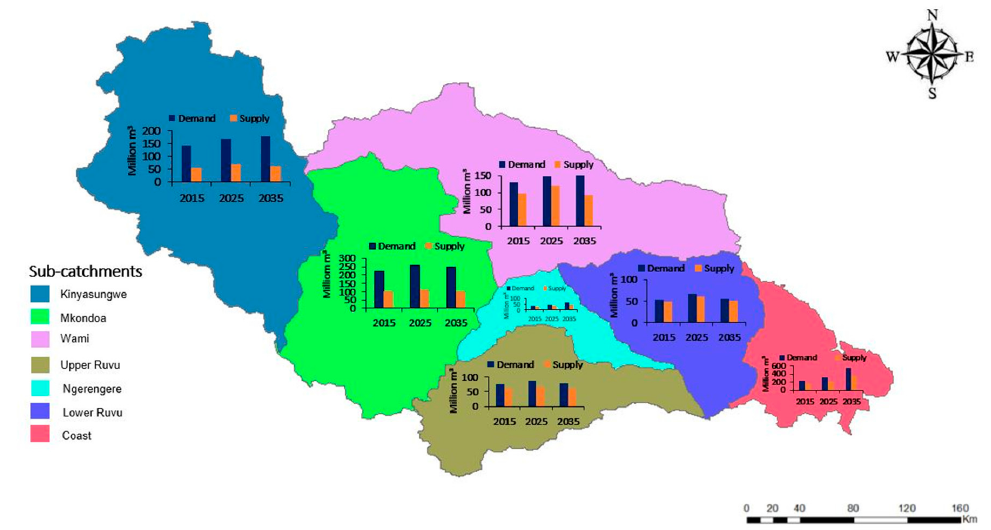
Figure 5. Projected spatial and temporal variation in water supply and demand in the Wami Ruvu basin.